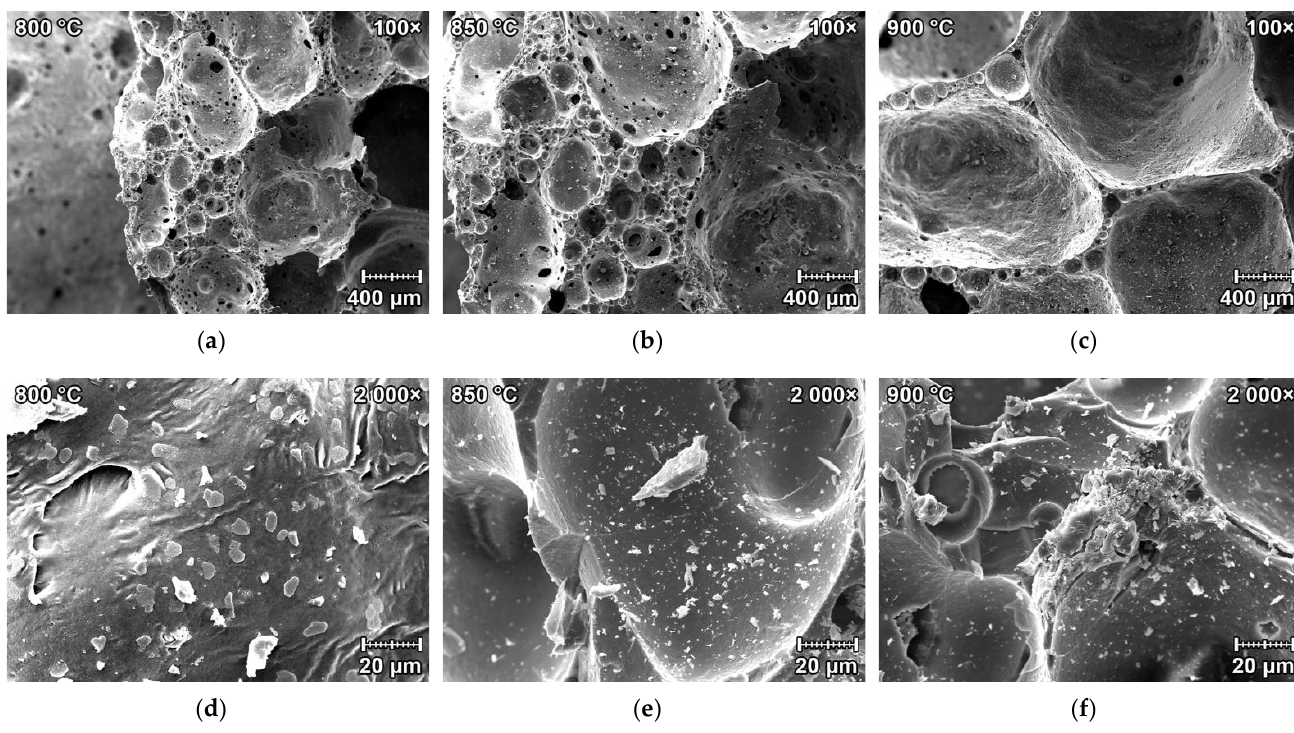
Figure 7. SEM microphotographs of the foamed waste diatomite samples: ( a ) sample fired at 800 °C with 100X magnification; ( b ) sample fired at 850 °C with 100X magnification; ( c ) sample fired at 900 °C with 100X magnification; ( d ) sample fired at 800 °C with 2000X magnification; ( e ) sample fired at 850 °C with 2000X magnification; ( f ) sample fired at 900 °C with 2000X magnification.